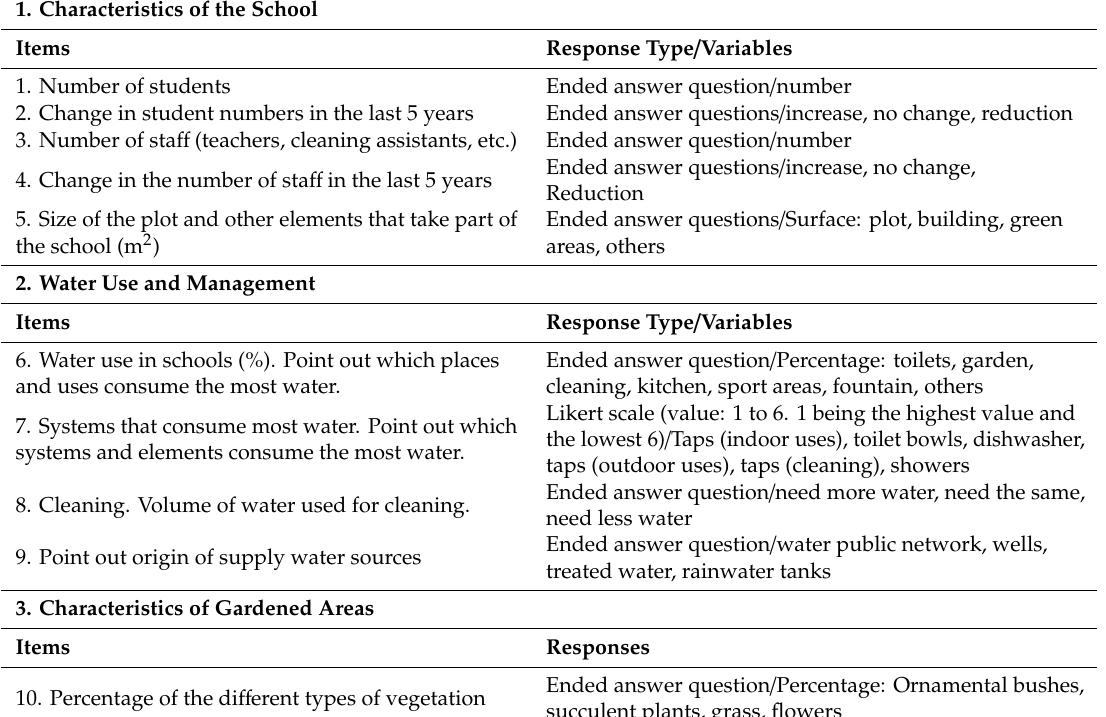
Table 1. Questionnaires sent to the school